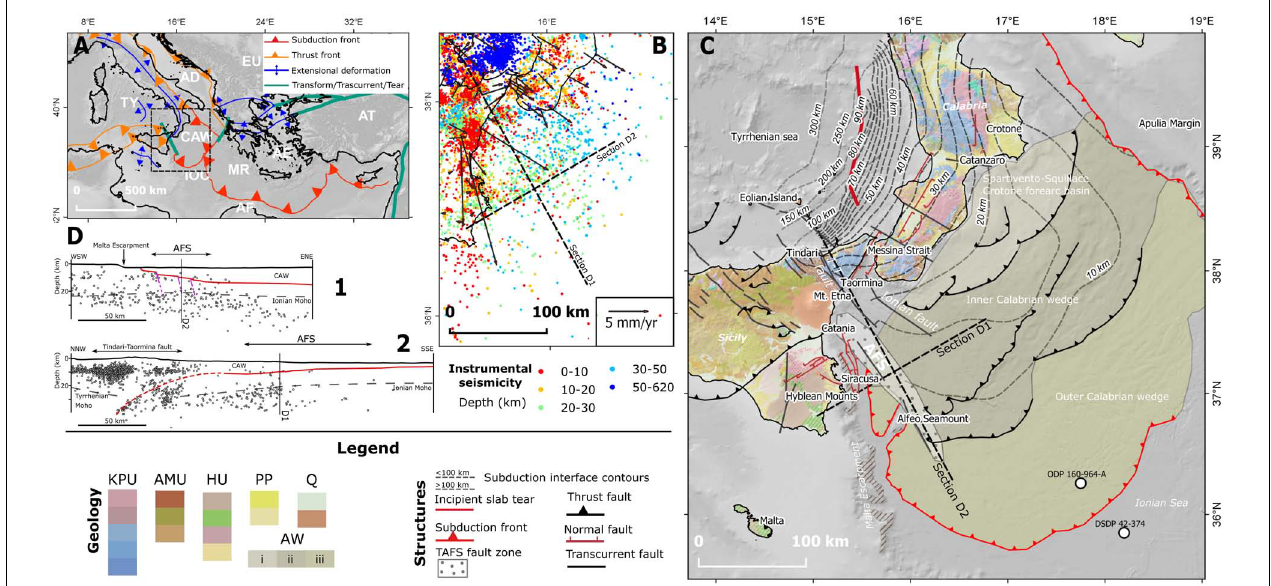
FIGURE 1 | (A) Tectonic sketch map of the Mediterranean region. AF, African plate; AT, Anatolian plate; AE, Aegean plate; AD, Adria microplate; EU, European plate; TY, Tyrrhenian Sea; CAW, Calabrian accretionary wedge; IOC, Ionian oceanic crust; MR, Mediterranean ridge. (B) Instrumental seismicity, color-coded as a function of depth, from the Italian Seismological Instrumental and Parametric Database, earthquake plotted are recorded in the time period 2005–2016 from ISIDe Working Group (2016). Velocity field from continuous GPS station in the 1998–2009 timespan for Sicily and Calabria plotted with a fixed Africa (Devoti et al., 2011). Velocity ellipses represent 1-sigma confidence errors. (C) Tectonic map of the Calabrian Arc. The dot-shaded polygon encloses the entire lithospheric tear, the AFS is sketched inside this polygon, that acts as the southwestern lateral termination of the Calabrian slab. The slab depth contours are from Maesano et al. (2017). The geological map is a synthesis from Compagnoni et al. (2011), Polonia et al. (2011, 2016), Barreca et al. (2016), Gutscher et al. (2016), Tiberti et al. (2017), and references therein. KPU, Calabrian and Peloritanian metamorphic units and Mesozoic sedimentary cover; AMU, Apenninic-Magherbian units; HU, Hyblean units; PP, Pliocene and Pleistocene deposits; Q, Alluvial and volcanic late Pleistocene to Holocene units; AW, Calabrian accretionary wedge (i – Crotone-Spartivento forearc basin; ii – Inner Calabrian wedge, pre-Messinian; iii— Outer Calabrian wedge, post-Messinian). White dots are ODP and DSDP drill locations from http://iodp.tamu.edu/. (D) Schematic structural sections with the seismicity in the rage 0.4–5.4 Ml (ISIDe Working Group, 2016) sampled within a buffer of 15 km around them. Section traces are in panels (B,C) . The red line represents the Calabrian subduction interface and the purple lines represent the AFS (both dashed where more uncertain), both from Maesano et al. (2017). The gray dashed lines represent the Tyrrhenian and Ionian Moho from Grad et al.